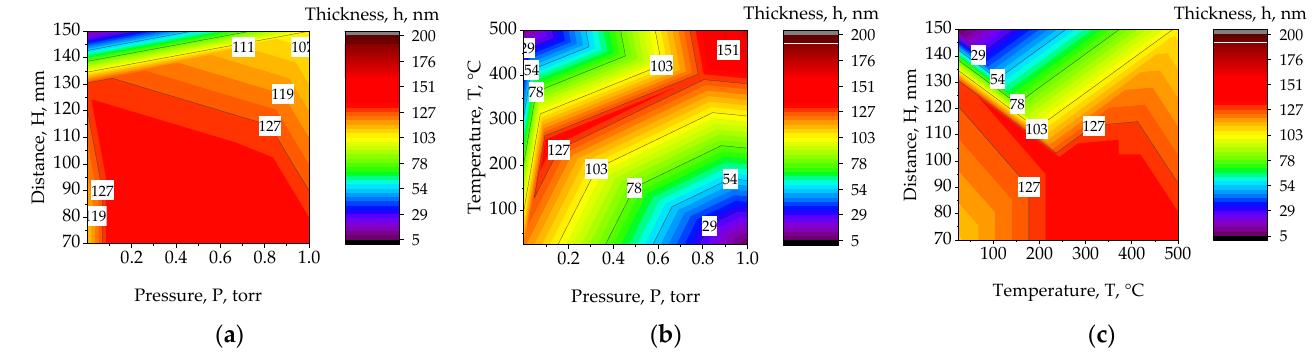
Figure 8. Plots of the dependence of the thin film thickness, h, on the main parameters of the technological process, T, P, H: ( a ) H and P; ( b ) T and P; ( c ) H and T.